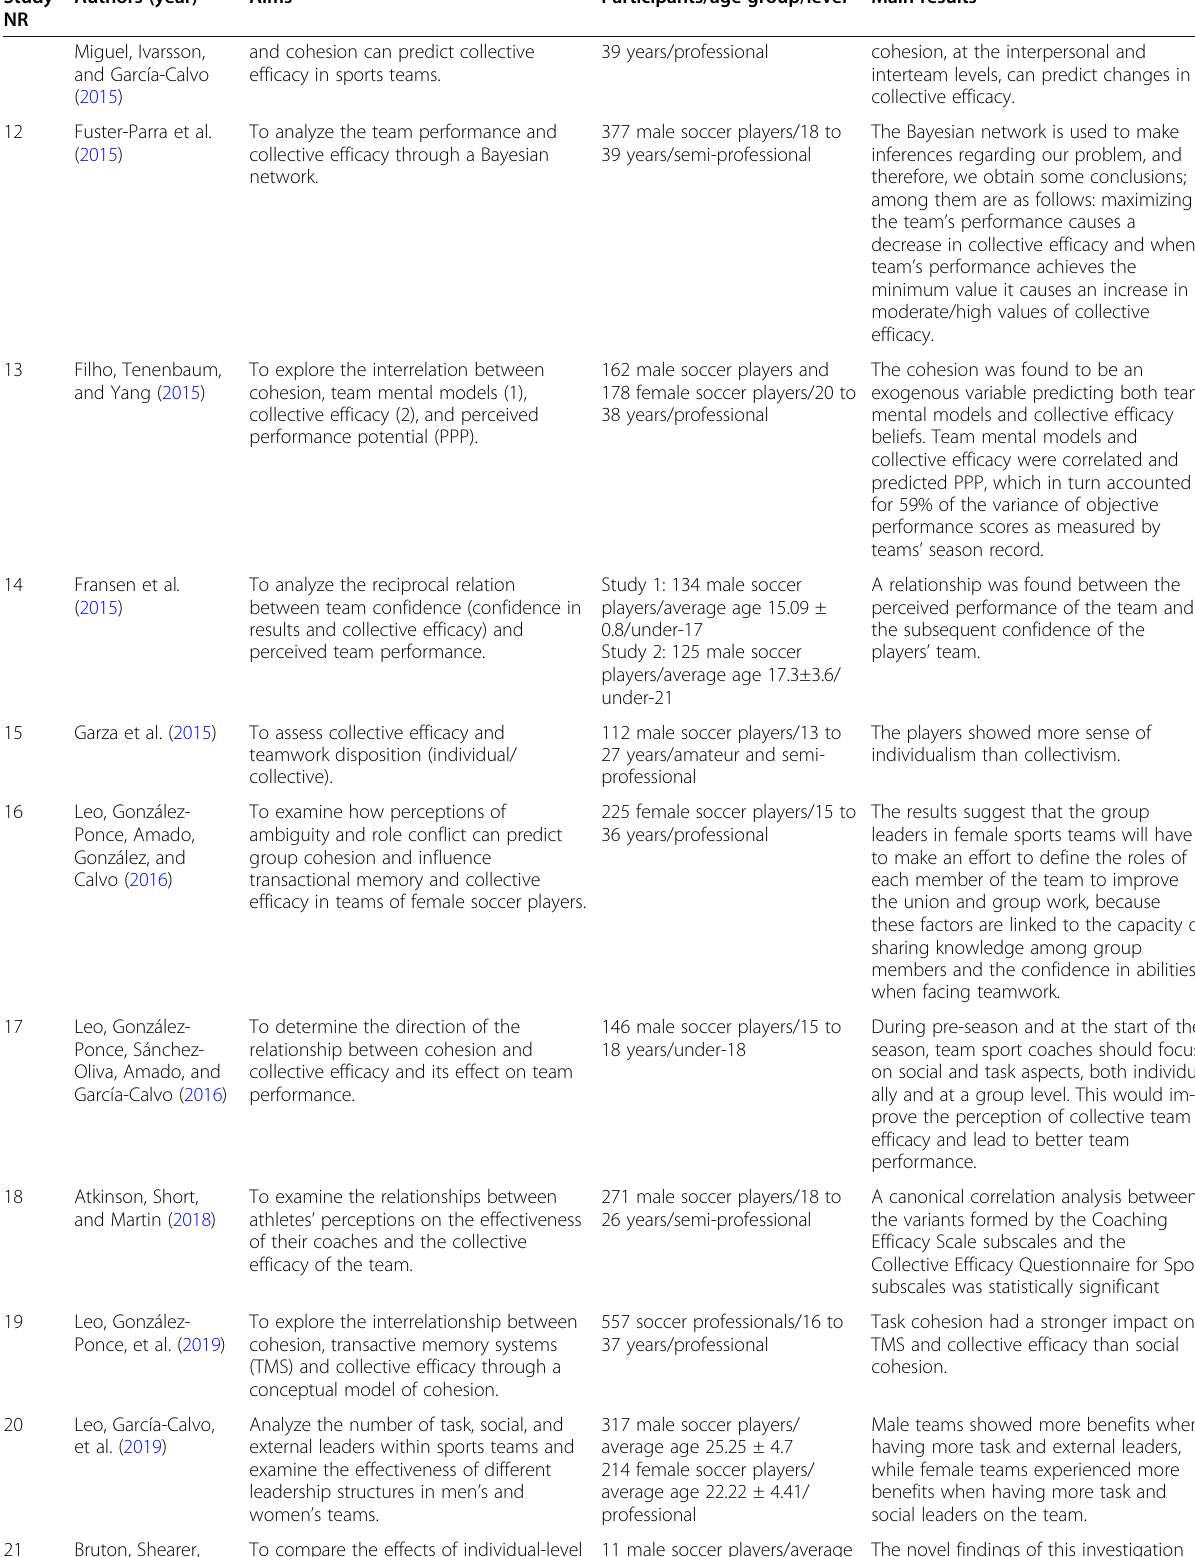
Table 1 Characterization of the studies included in the systematic review